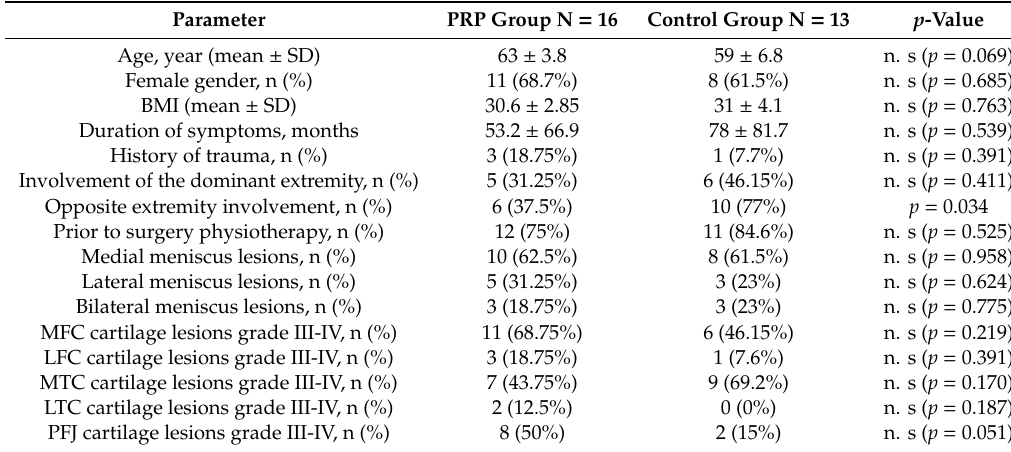
Table 1. Clinical and baseline characteristics.